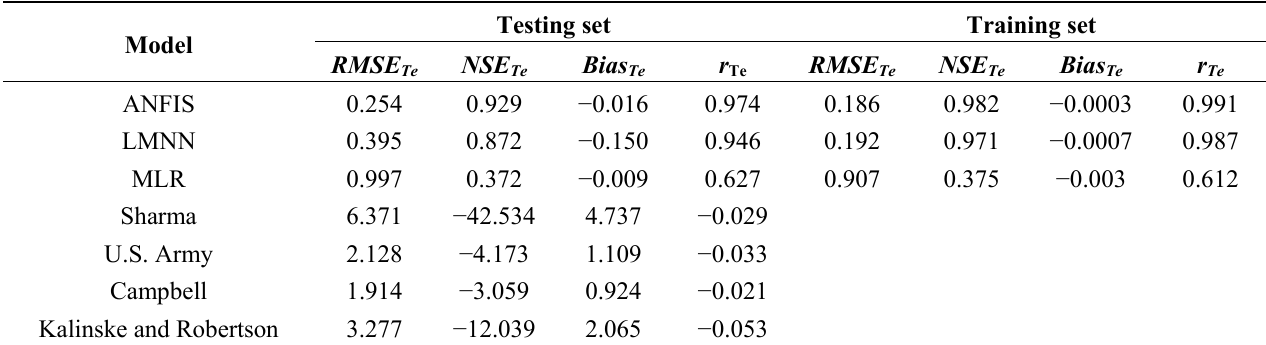
Table 4. Performance statistics for the adaptive neural-based fuzzy inference system (ANFIS), feed-forward Levenberg-Marquardt artificial neural network (LMNN), multiple linear regression (MLR), and empirical models using true error ( T ). e Testing set Training set Model RMSE NSE Bias r RMSE NSE Bias r Te Te Te Te Te Te Te Te ANFIS 0.254 0.929 − 0.016 0.974 0.186 0.982 − 0.0003 0.991 LMNN 0.395 0.872 − 0.150 0.946 0.192 0.971 − 0.0007 0.987 MLR 0.997 0.372 − 0.009 0.627 0.907 0.375 − 0.003 0.612 Sharma 6.371 − 42.534 4.737 − 0.029 U.S. Army 2.128 − 4.173 1.109 − 0.033 Campbell 1.914 − 3.059 0.924 − 0.021 Kalinske and Robertson 3.277 − 12.039 2.065 −